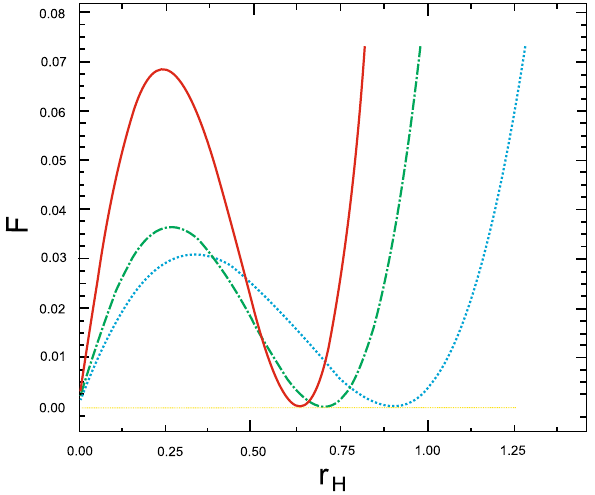
Fig. 4 Graphs of F × r H in the case of the positive cosmological constant with T HP = 0 . 049474913904. The solid curve are for (cid:2) = 0 with N = 4 . 2910, the dot-dashed curve for (cid:2) = 0 . 5 with N = 1 . 5, and the dotted curve for (cid:2) = 0 . 6448 and N = 0 . 5